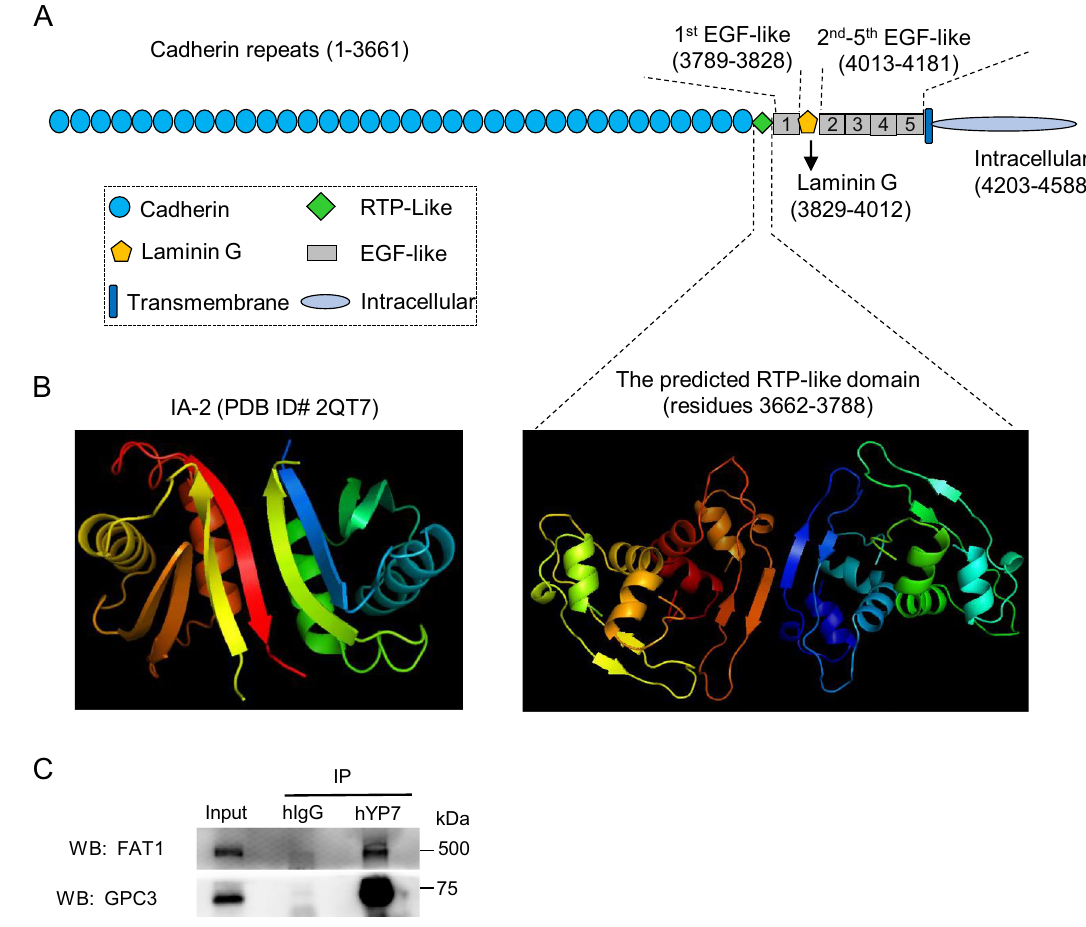
Figure 1. The structure of FAT1 and its co-IP with GPC3. ( A ) Schematic diagram of FAT1 structure. ( B ) Structural model of FAT1 (residues 3662-3788). The model was built on the crystal structure of the human receptor tyrosine phosphatase IA-2 (insulinoma- associated protein 2) (PDB ID# 2QT7), and FAT1 (residues 3662-3778) structure resembled the extracellular domain of IA-2. The 3D structural model was made by using the software SWISS-MODEL (https ://swiss model .expas y.org/). ( C ) co-IP of endogenous FAT1 by GPC3 in HepG2 cells. GPC3 was pulled down by the hYP7 antibody. The co-IP of FAT1 was detected by anti-FAT1 antibody. Pooled hIgG was used as isotype control of hYP7. The original blots were presented in Supplementary Figure